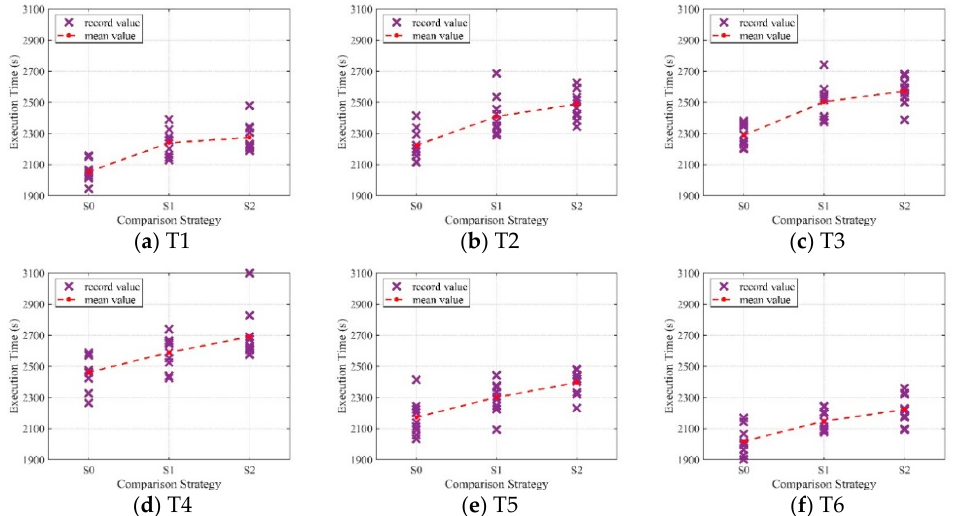
Figure 7. Execution time of three comparison strategies for T1 to T6 using the SLIC algorithm with four executors.